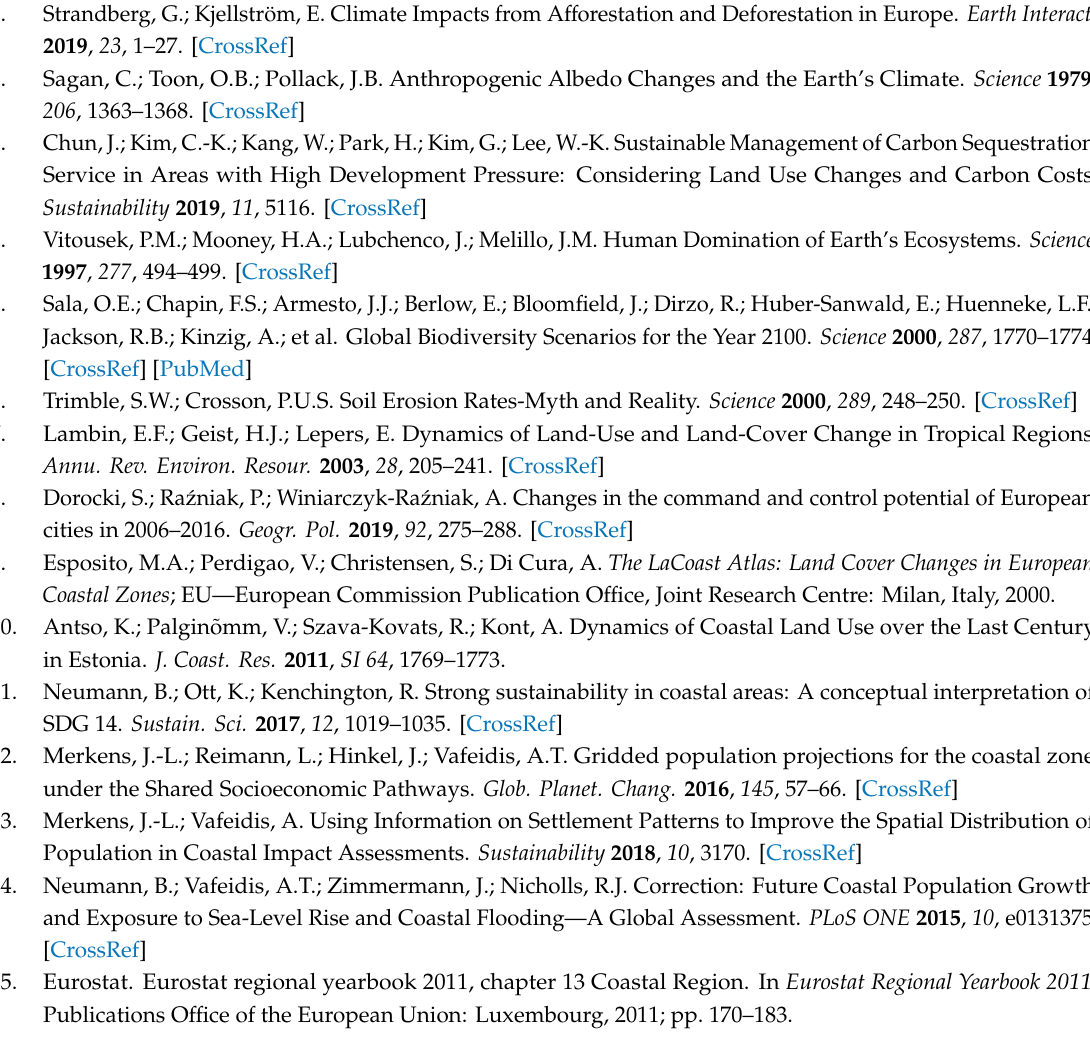
Figure A3. Red marked CLC changed polygons used for data verification.